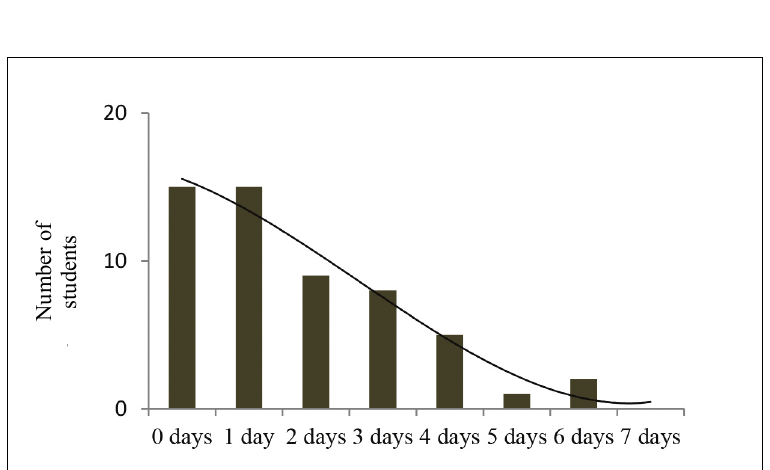
Figure 3. Frequency of doing the third men - tioned sport on a weekly